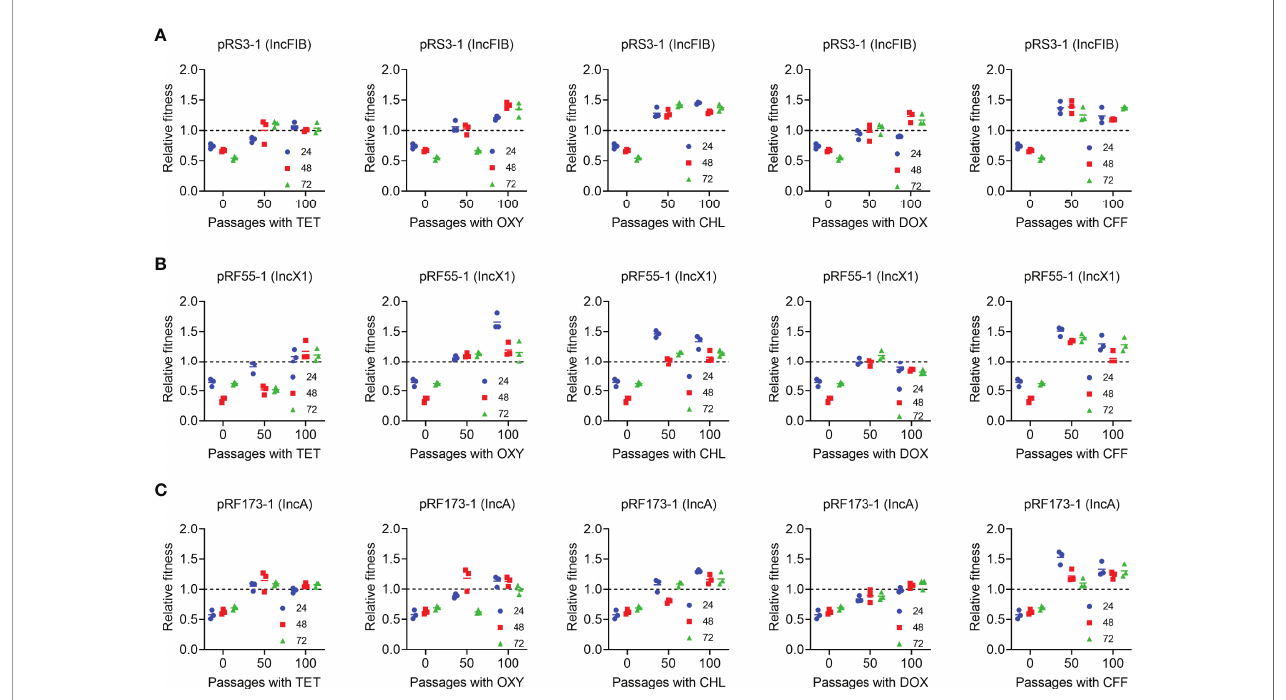
FIGURE 6 | Fitness cost changes of three transformants carrying different types of tet (X4)-bearing plasmids in the presence of fi ve commonly used drugs in clinic involve tetracycline (TET), oxytetracycline (OXY), chlortetracycline (CHL), doxycycline (DOX), and ceftiofur (CFF). In vitro competitive experiments of three transformants including pRS3-1 [IncFIB, (A) ], pRF55-1 [IncX1, (B) ], and pRF173-1 [IncA, (C) ], which were competed with a reference strain E. coil TOP10 under the pressure of fi ve drugs and last for 100 passages. The relative fi tness was calculated at 24, 48, and 72